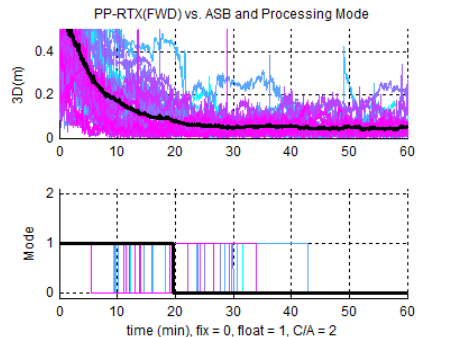
Figure 7: Forward PP-RTX vs. ASB and Processing Mode